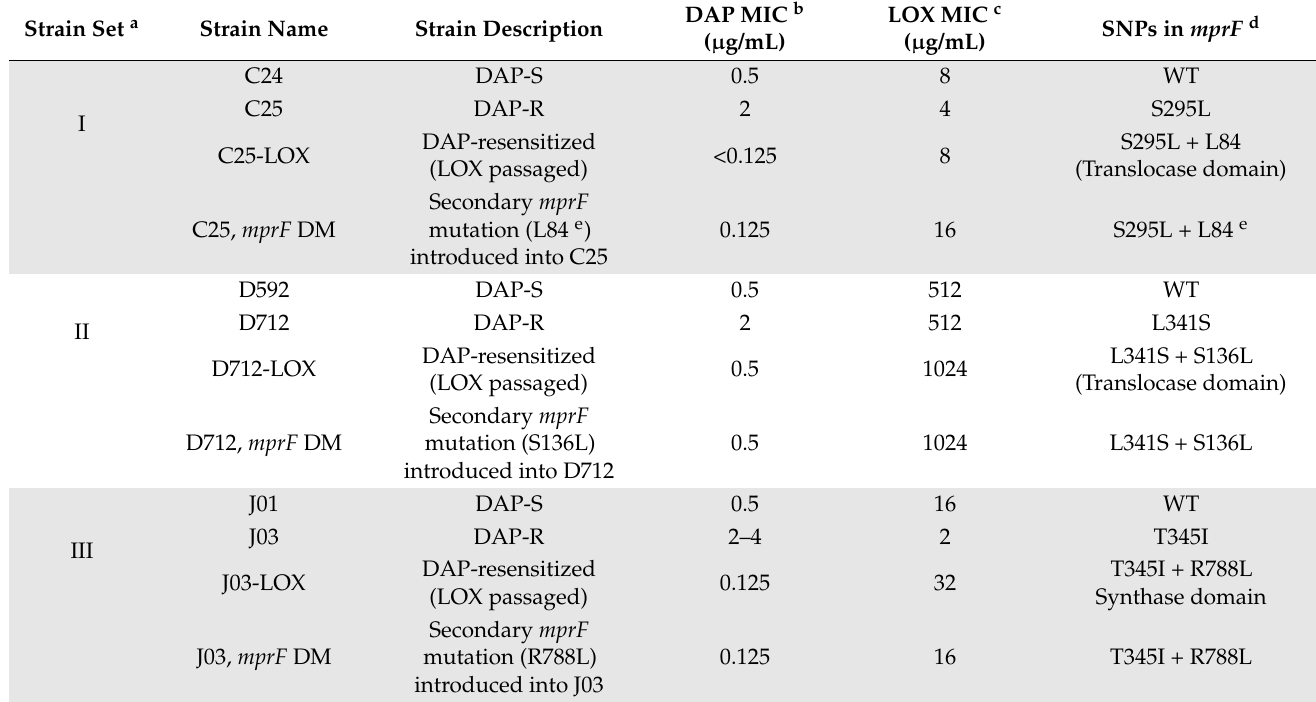
Table 1. List of study strains and their DAP